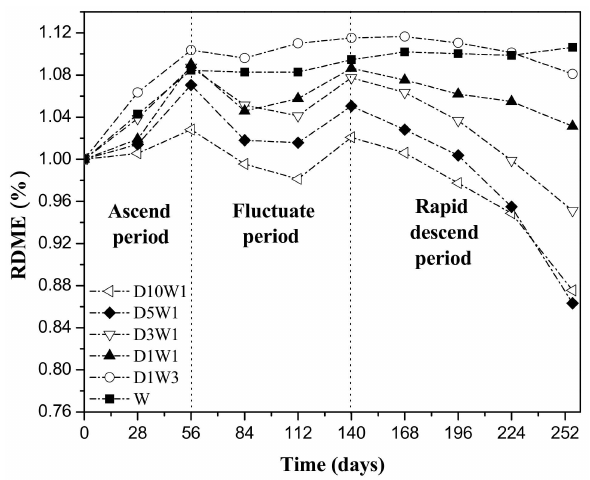
Figure 6. Change of RDEM of specimens exposed to sulfate solution under di ff erent drying–wetting cycle